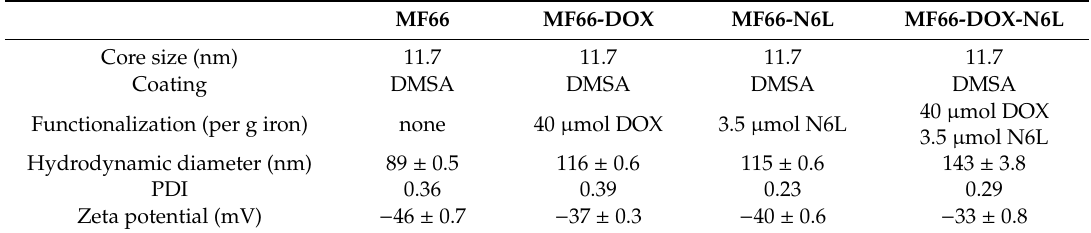
Table 1. Characterization of non- / functionalized MF66-magnetic nanoparticles